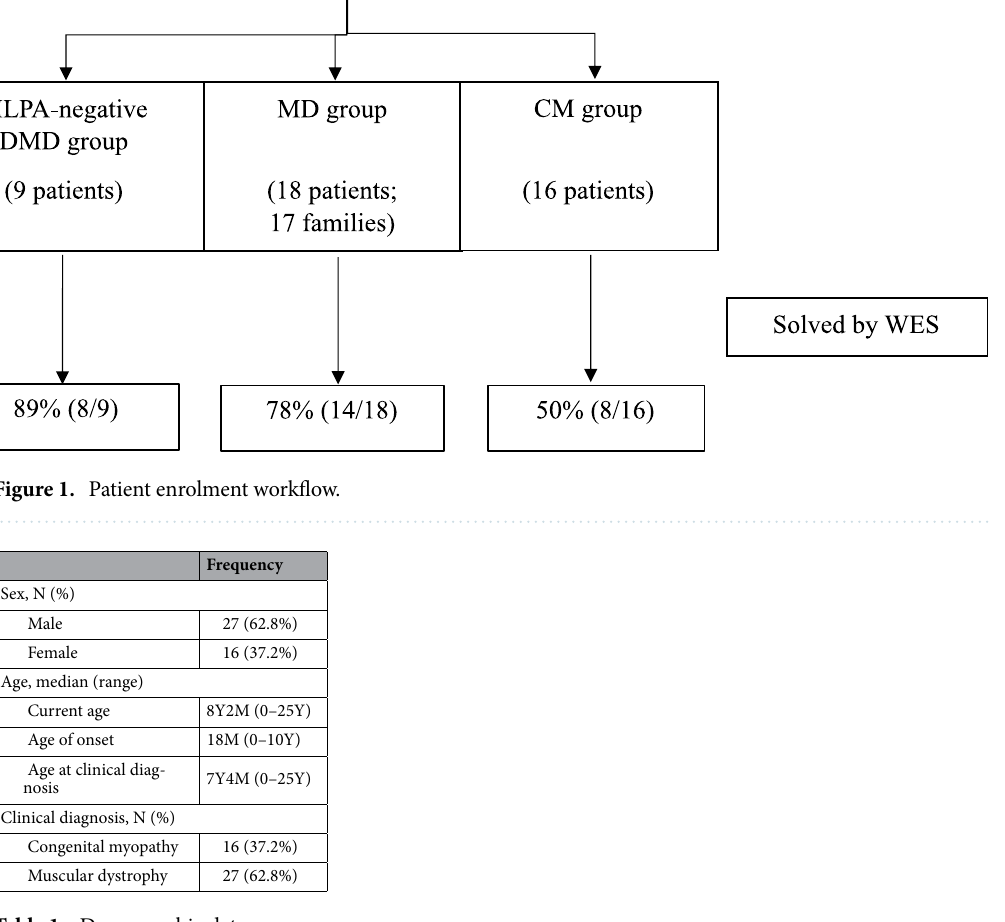
Table 1. Demographic